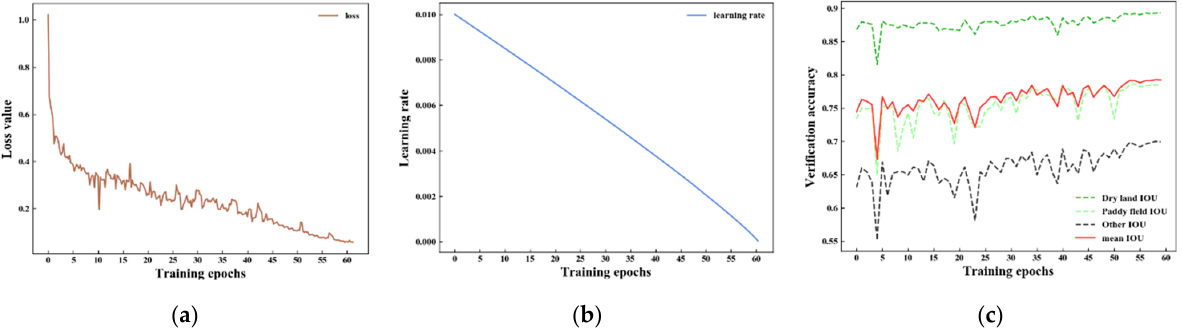
Figure 9. The training diagram of the cropland extraction network in Changchun city in the spring Jilin ‐ 1 data: ( a ) the decreasing curve of training loss, ( b ) the learning rate curve, and ( c ) the validation set accuracy curve.